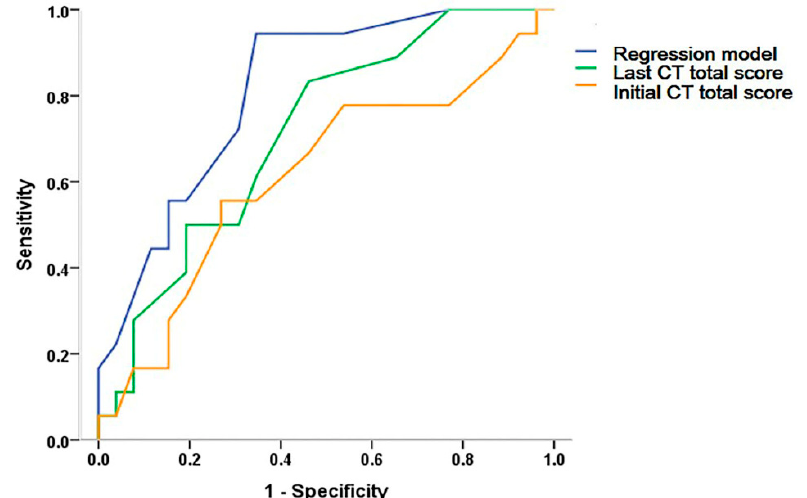
Figure 2. Receiver operating characteristic curve analysis for predicting tuberculous mycobacterial pulmonary disease (NTM-PD). The area under the curve of the total CT score at treatment initiation, treatment termination, and regression model were 0.618 (95% CI = 0.443–0.792), 0.713 (95% CI = 0.561–0.864), and 0.814 (95% CI = 0.689–0.939), respectively.